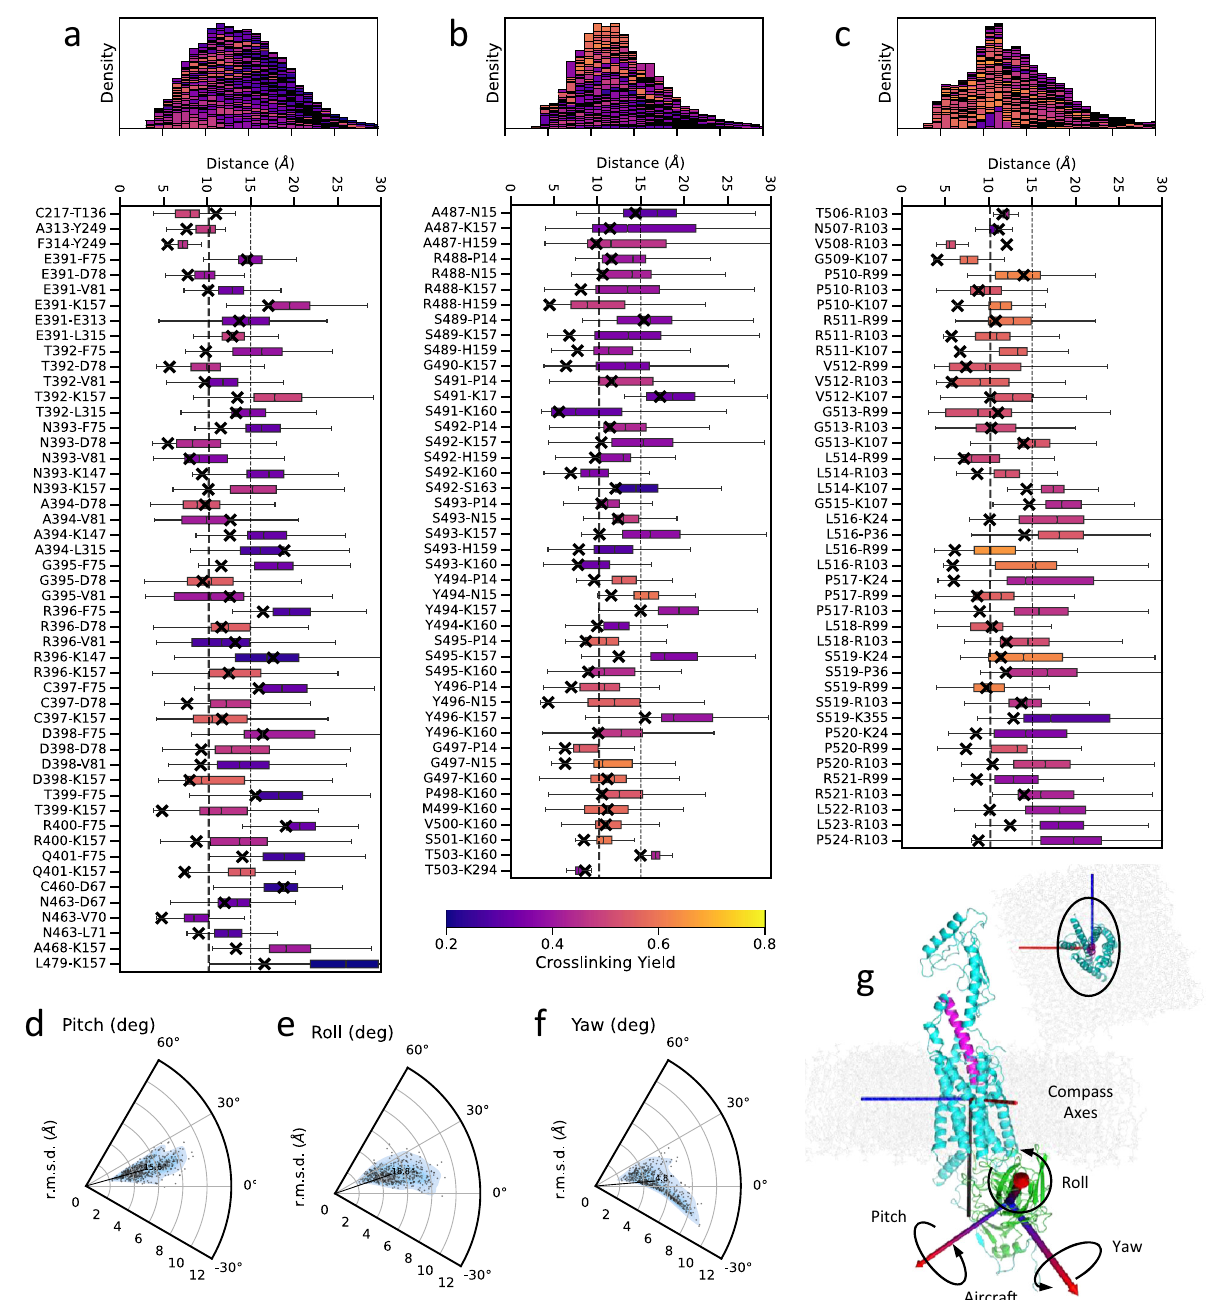
Fig. 5 | Dynamics of the assembled complex based on M 2 R-arr2 template. a – c